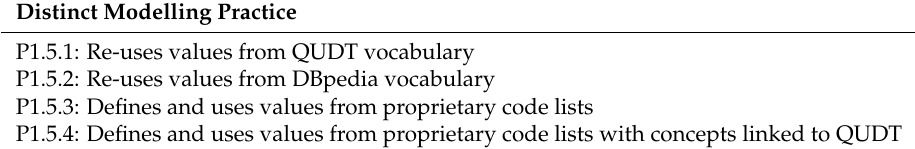
Table 13. Distinct modelling practices of data portals regarding the values (code list) of the unit of